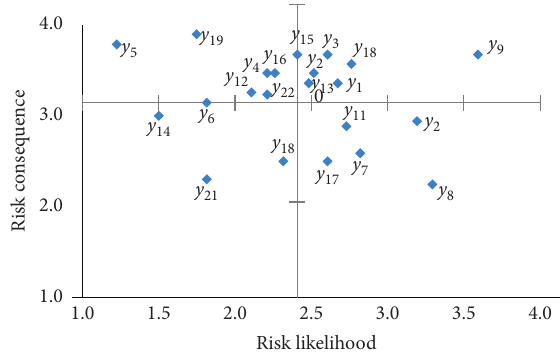
Figure 2: Distribution matrix of risk